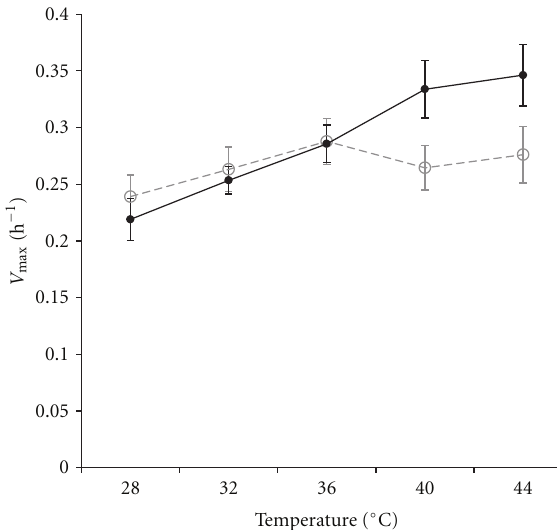
Figure 4: Rarefaction curve constructed with the abundances of the di ff erent phylotypes (16S rDNA) in winter and summer samples. Error bars represent the confidence limits for the distributions. (cid:2) Winter samples (January 2004 and 2005); O summer samples (August 2003 and 2005).